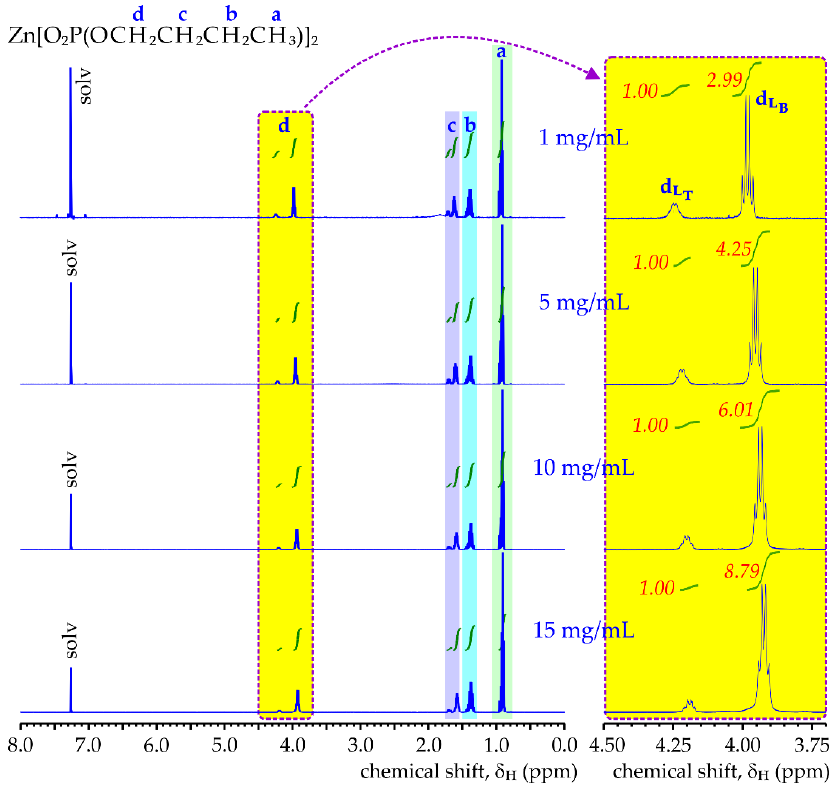
Figure 5. 1 H NMR spectra recorded for different mass concentrations of ZnDBP (1–15 mg/mL) in CDCl 3 at: 0–8 ppm region (left side) and 3.7–4.5 ppm region (right side). Selected signal integrals are presented as green curves together with their values (red fonts). Abbreviations: solv—solvent residual peak, d LT —signal of POC H 2 C 3 H 7 group within the terminal (RO) 2 PO 2 ligand, d LB —signal of POC H 2 C 3 H 7 group within the bridging (RO) 2 PO 2 ligand. The 1 H NMR signals were assigned to the different groups of protons appearing within the ZnDBP formula using small letters a–d.